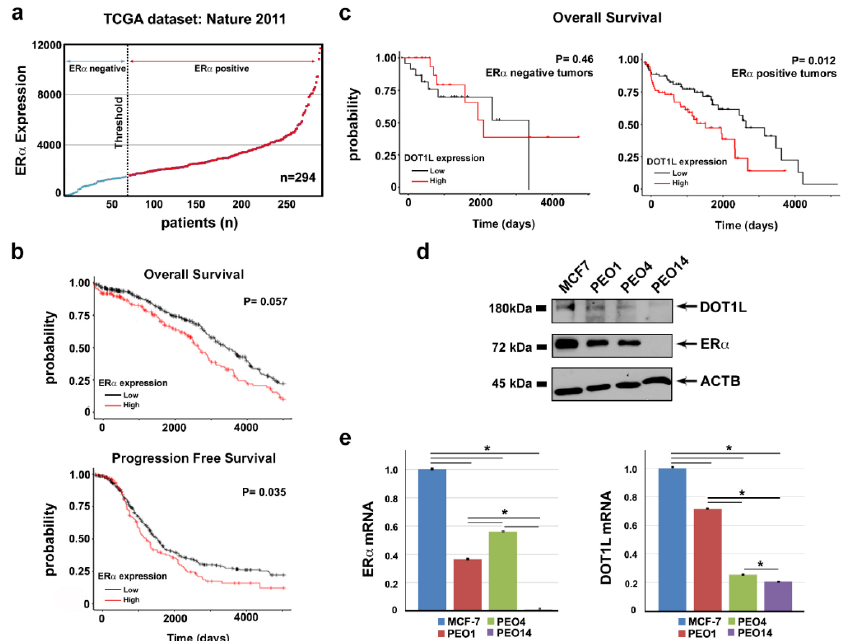
Figure 1. ERα and DOT1L expression in HGSOC tumors. ( a ) ERα mRNA expression in HGSOC from a TCGA cohort. The first quartile, relative to ERα expression level in the tumor, was set as threshold for ERα expression. ( b ) Kaplan-Meier curves of overall survival and progression-free survival for HGSOC patients with respect to an ERα mRNA expression level (low expression: values below first quartile, high expression: values above third quartile). ( c ) Kaplan-Meier curves showing the overall survival relative to DOT1L mRNA expression level (low expression: values below the first quartile, high expression: values above the third quartile) in ERα -negative (left) and ERα -positive (right) HGSOC tumors. Western blots ( d ) and RT-qPCR ( e ) of ERα and DOT1L expression levels in PEO1, PEO4, and PEO14 ovarian cancer cells compared to MCF-7 breast cancer cells. Data are presented as the mean ± SD of three independent replicate RTqPCR assays (* p ≤ 0.05).